Question: Which visualization type does this figure use?
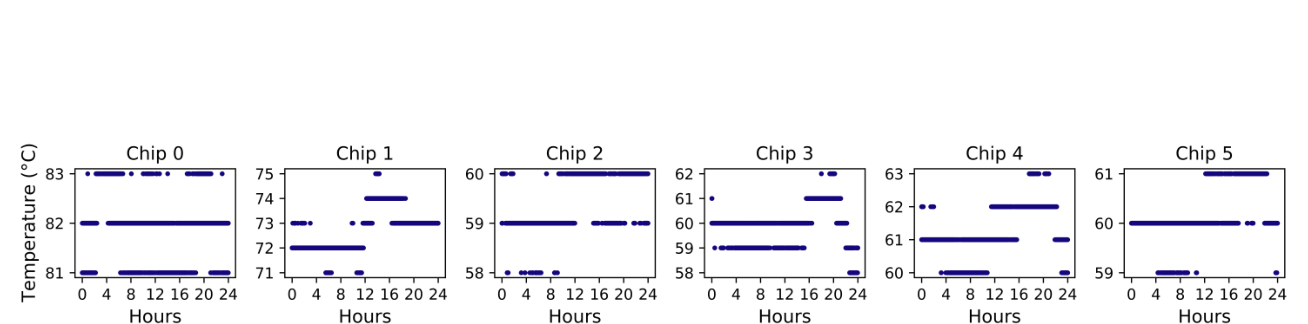
Answer: line